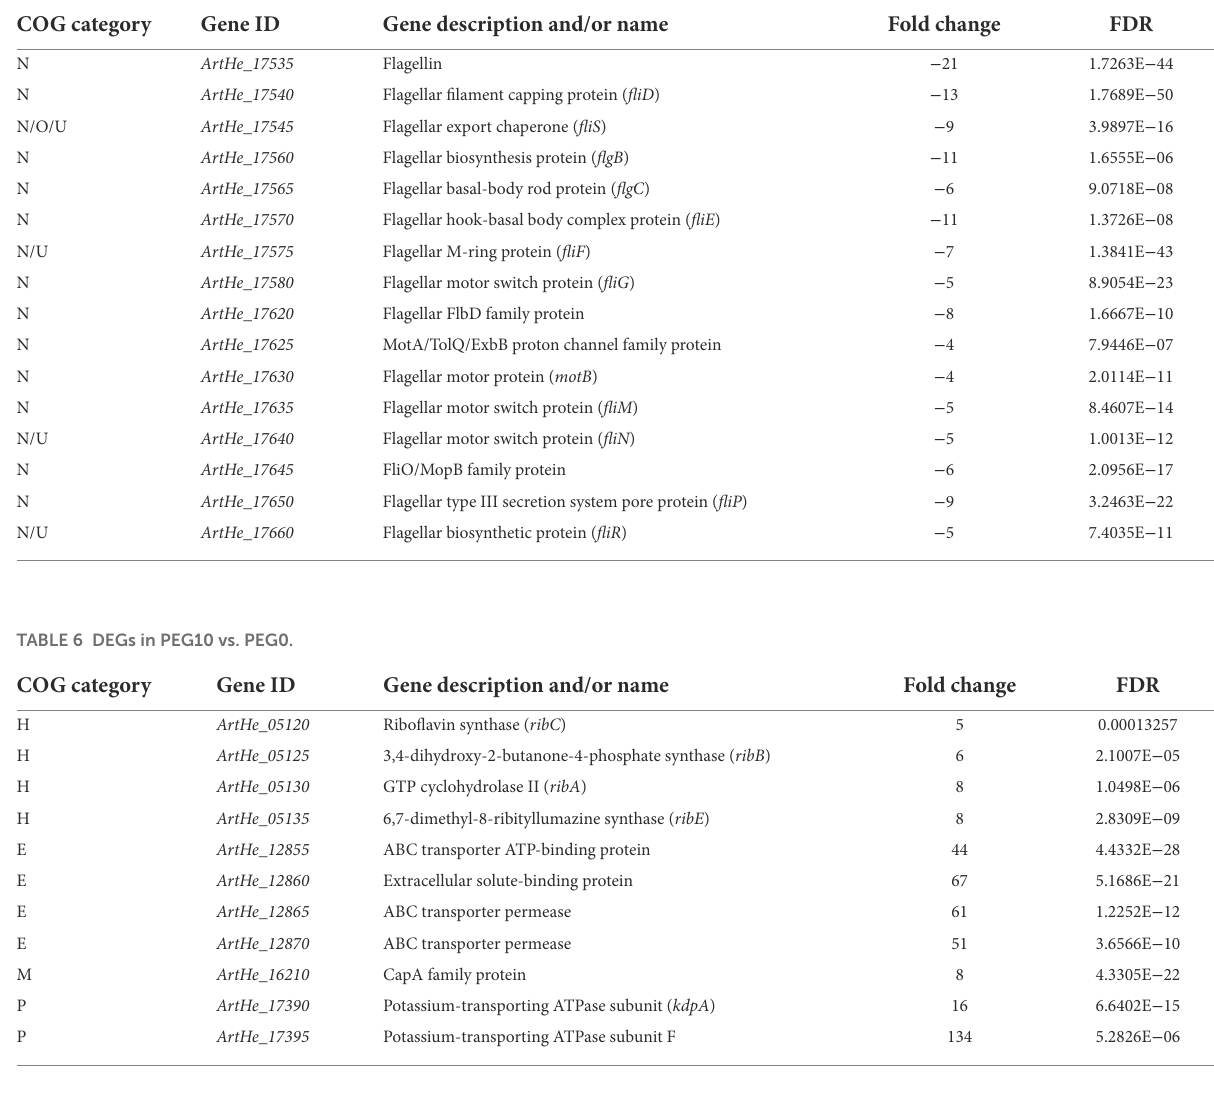
TABLE 5 DEGs involved in flagellum biosynthesis in PEG35 vs. PEG0.